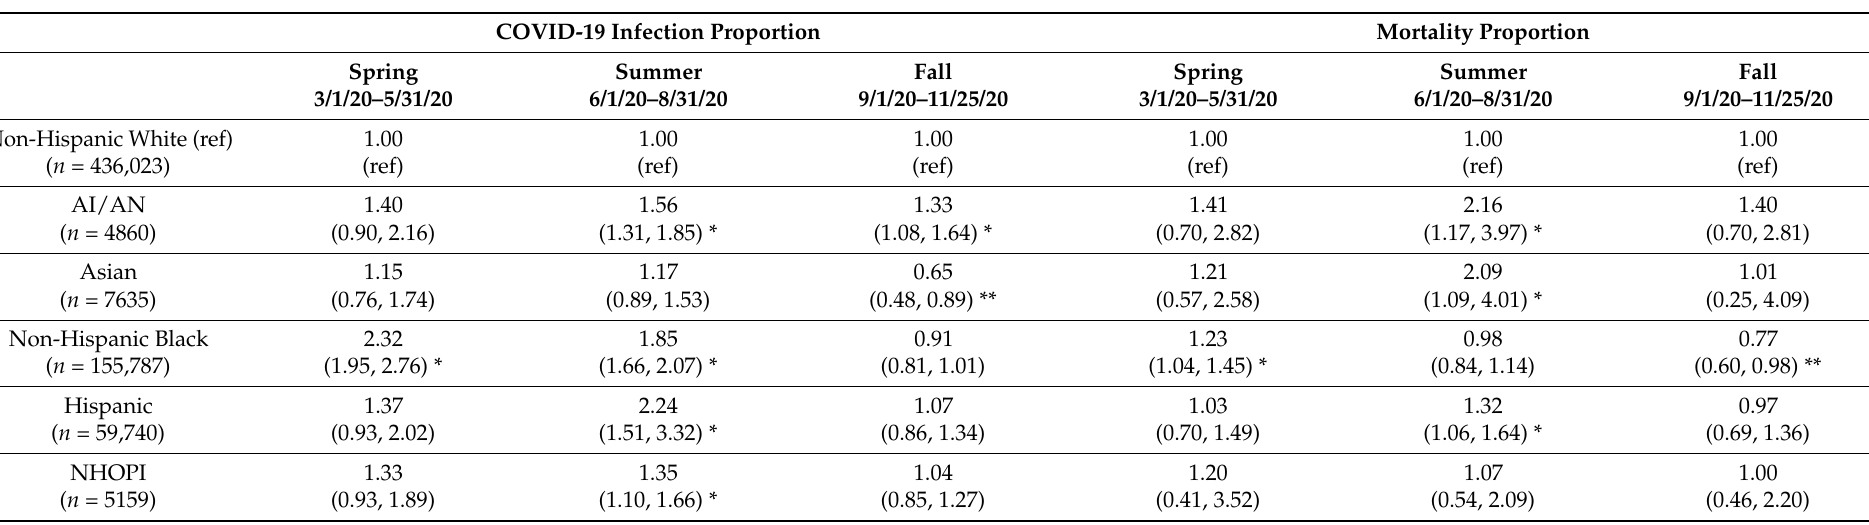
Table 4. Adjusted odds ratios of COVID-19 infection among veterans who were evaluated for COVID-19 at VHA and odds ratios of mortality among veterans who tested positive for COVID-19 by race/ethnicity over